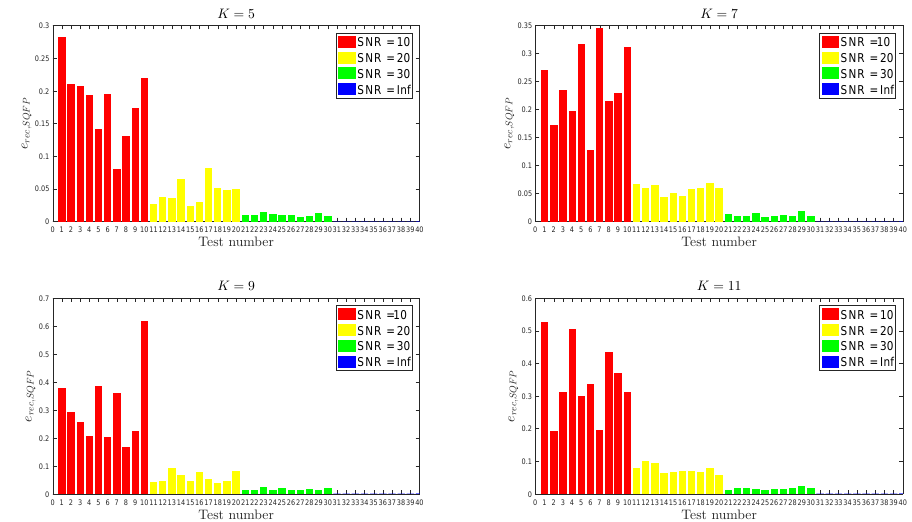
Figure 3. Recovery errors for SQFP for matrix conditioning of